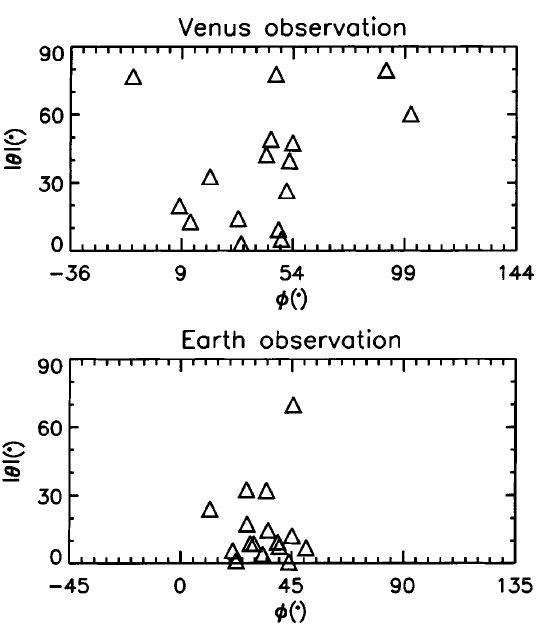
Fig. 2. Normal’s azimuth ( / ) and elevation ( h ) for sector boundaries at Venus ( upper panel ) and Earth ( lower panel ). The normals tend to be lying between the radial direction and the direction perpendicular to the spiral direction and close to ( (cid:20) 45 (cid:14) ) the solar equatorial plane, especially at